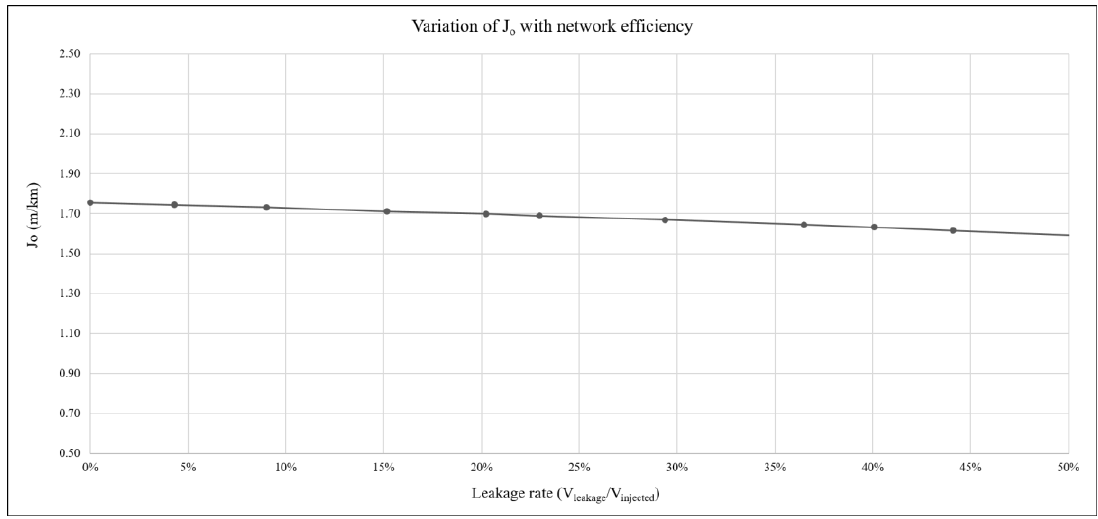
Figure 10. Variation of J 0 with network efficiency (case 1, steady network).